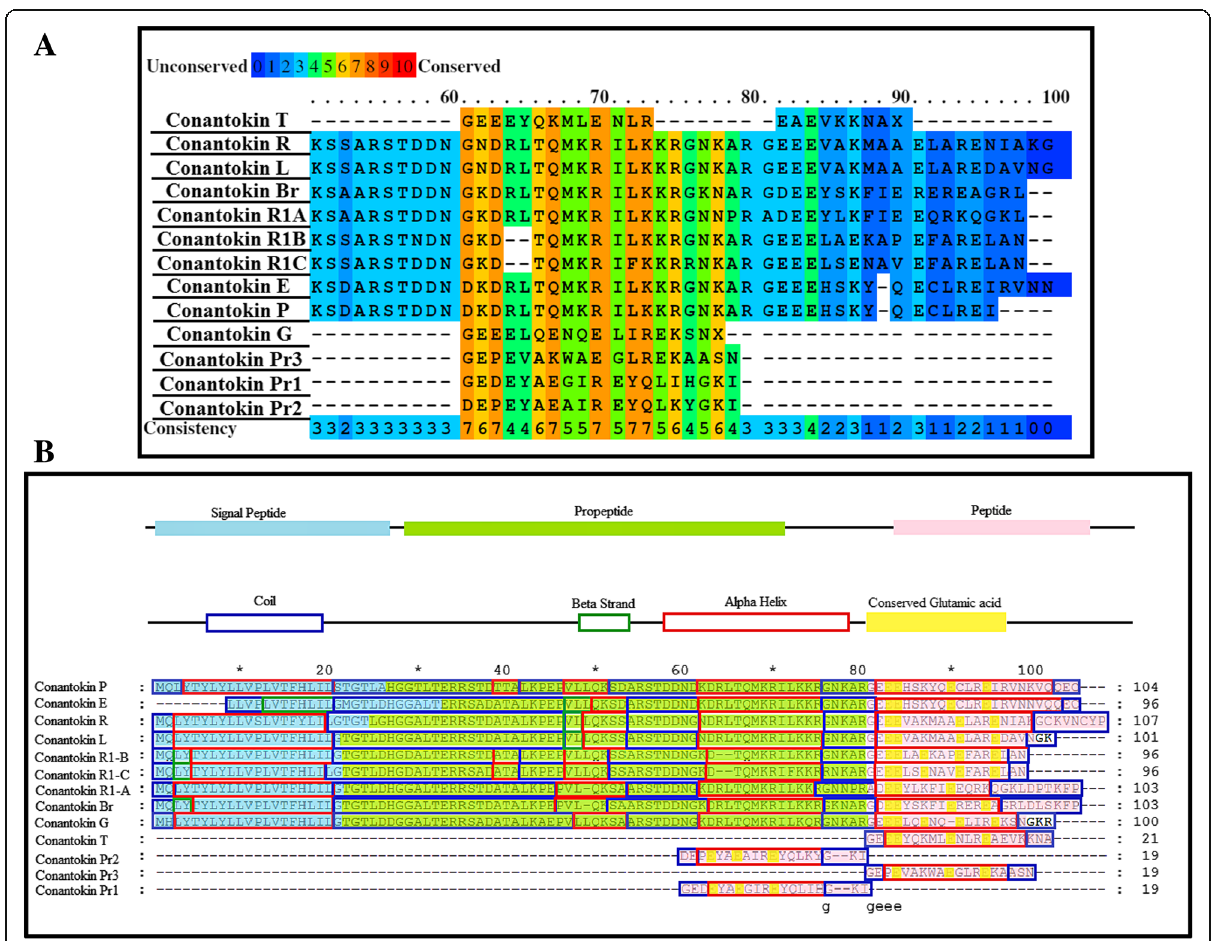
Fig. 1 a Conserved residues highlighted in conantokins. b Predicted secondary structures of all conantokins aligned